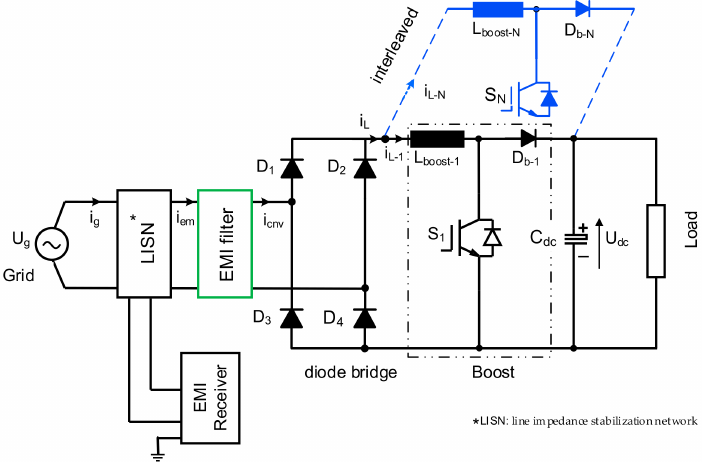
Figure 1. Block diagram of an interleaved boost power factor correction (PFC) converter including impedance stabilizing network (LISN), electromagnetic interference (EMI) receiver, and EMI